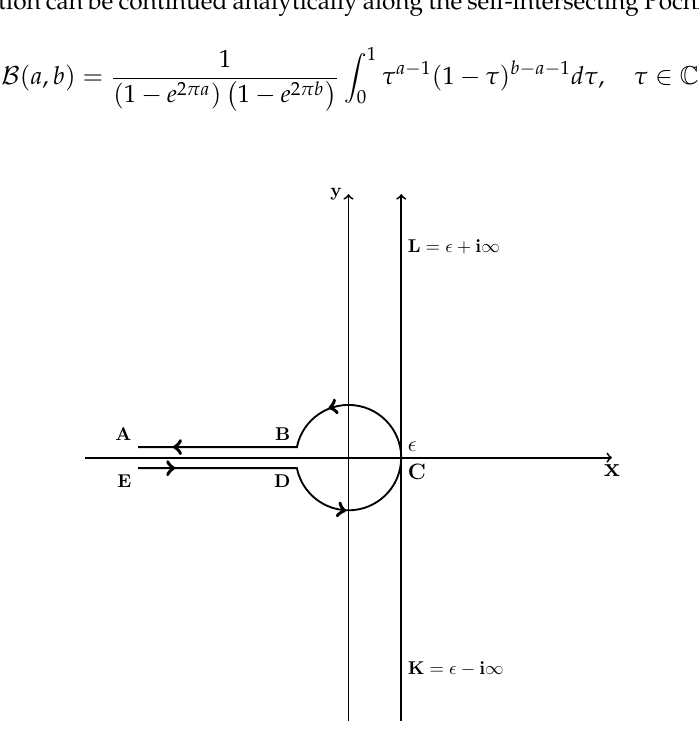
Figure A1. The Hankel contour Ha − ( (cid:101) ) and the Bromwich contour Br + ( (cid:101) ) Figure 1. The Hankel contour Ha − ( (cid:15) ) and the Bromwich contour Br + ( (cid:15) )